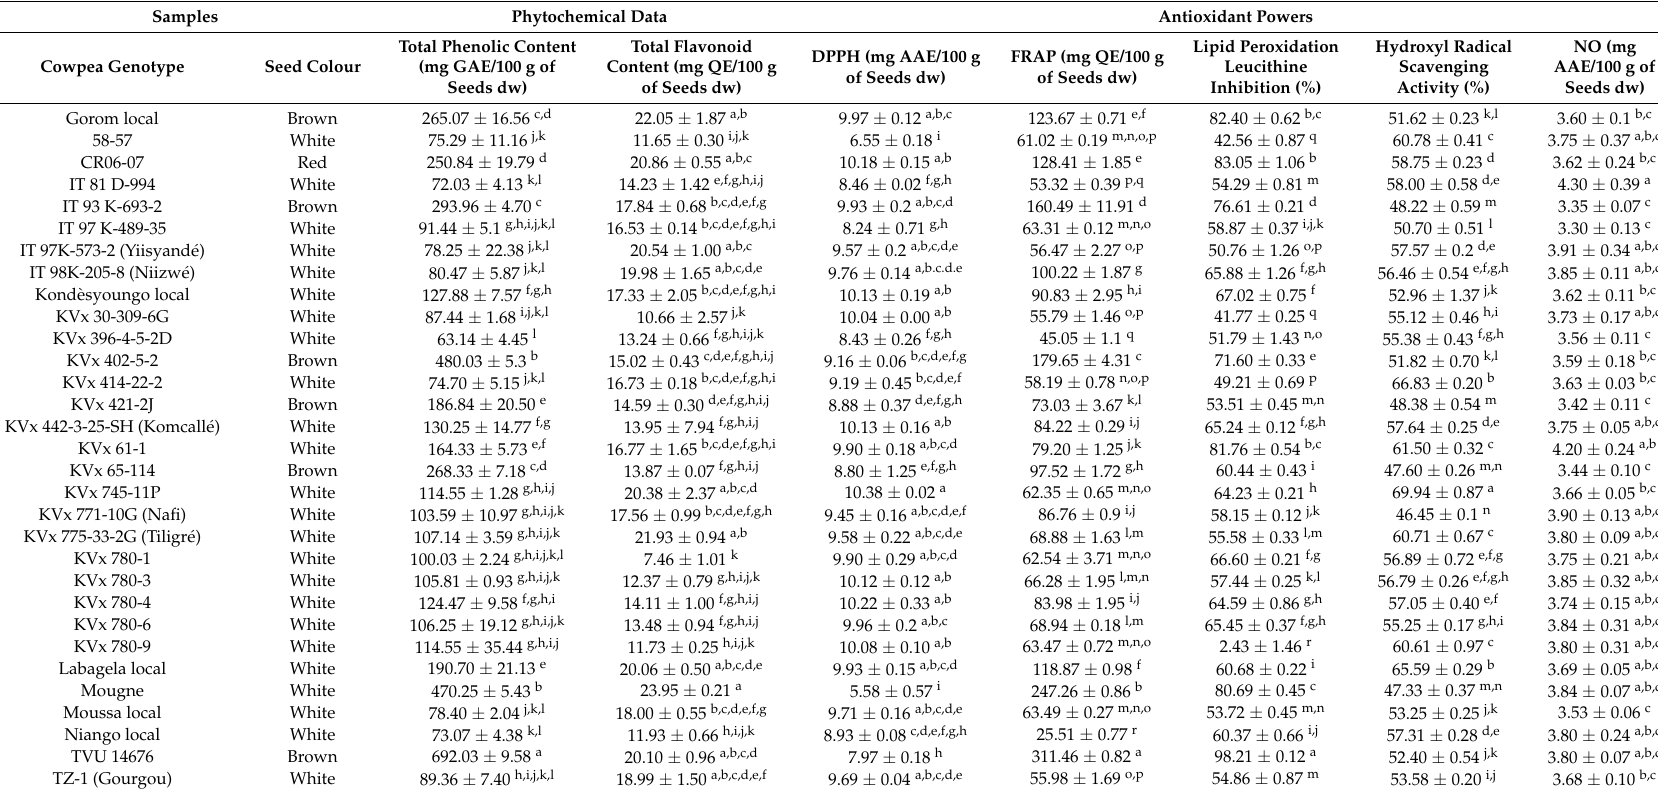
Table 1. Phenolic content and antioxidant properties of cowpea